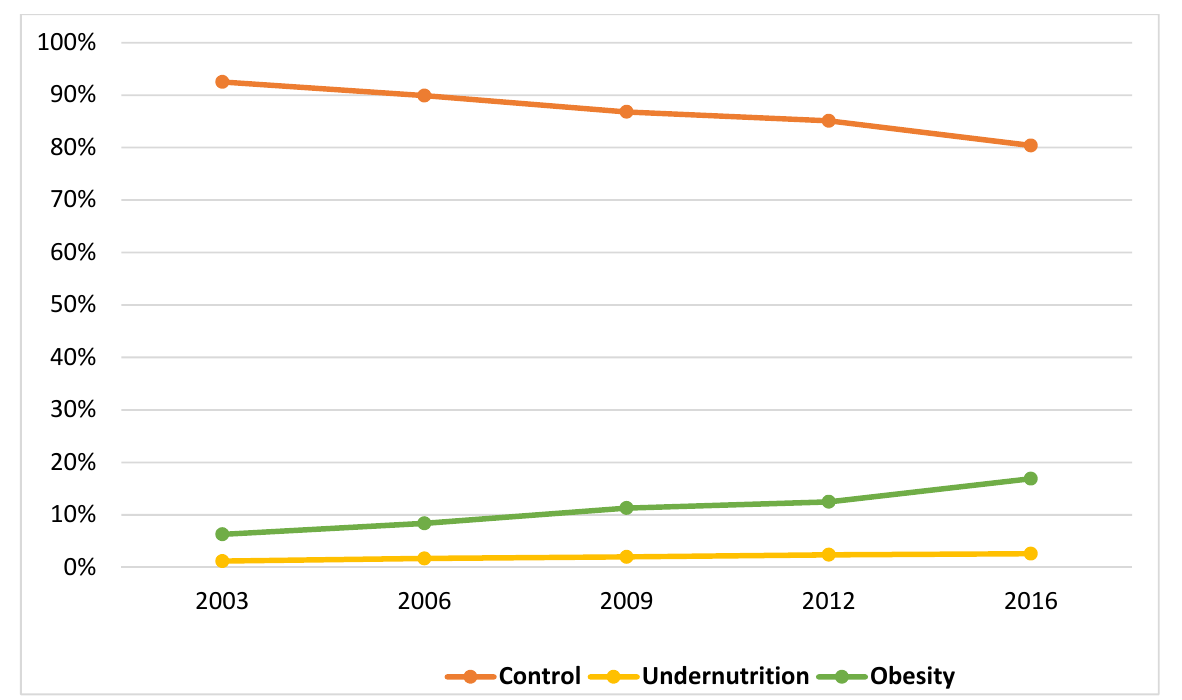
Figure 1. Increasing proportion of undernutrition and obesity among pediatric population with acute pancreatitis between 2003 and 2016.